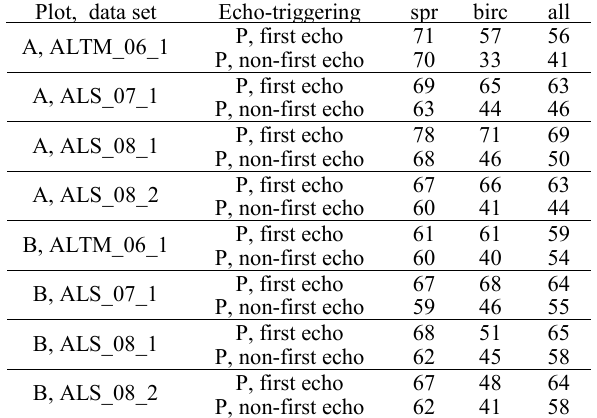
Table 4. Echo-triggering probabilities in understory trees in pulses that had mathematically intersected an understory tree.